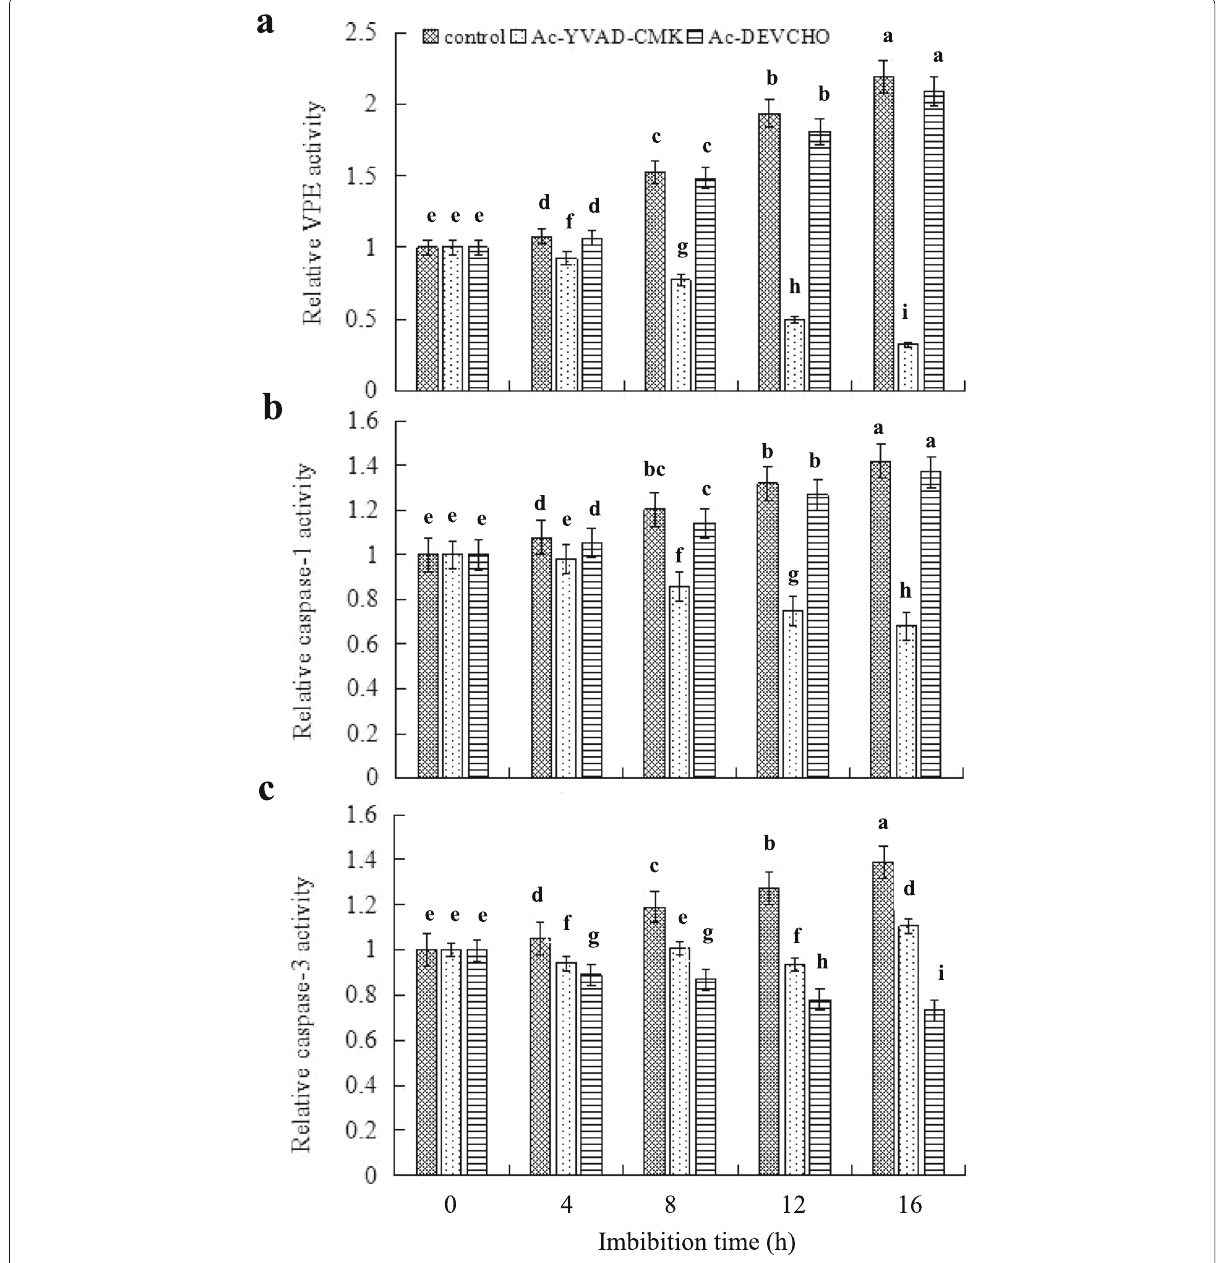
Fig. 3 OsVPE exhibited caspase-1-like enzymatic activity. Aleurone layers were stripped from the intact seeds imbibed for 12 h, and then the isolated layers were pre-incubated in a solution containing distilled water (control) alone or 10 μ M Ac-YVAD-CMK (caspase-1 inhibitor), and 10 μ M Ac-DEVD-CHO (caspase-3 inhibitor) alone or a combination for 0, 4, 8, 12, and 16 h. Then, the activities of VPE ( a ), caspase-1 ( b ), and caspase-3 ( c ) were measured. Error bars represent the means ± s.d., n = 3 biological independent experiments with at least three replicates for each. Bars with different alphabets show significant different at P < 0.05 by Duncan’s multiple range test